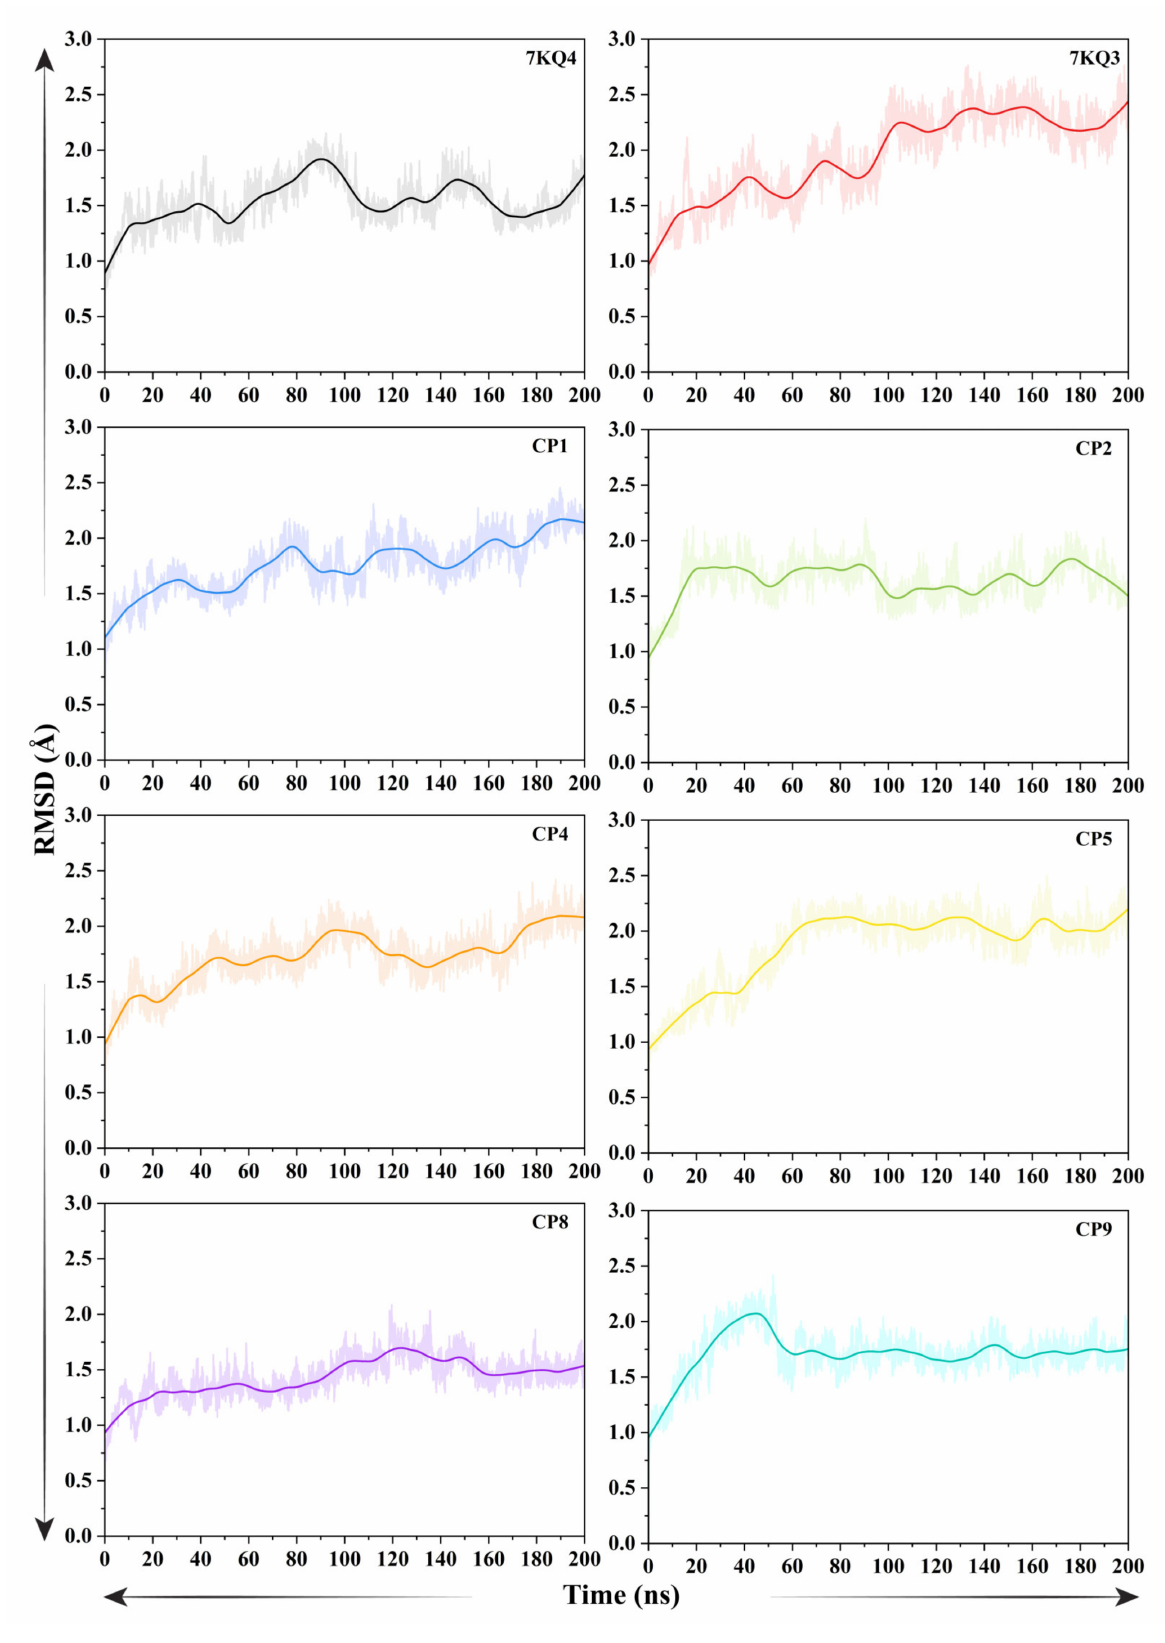
Figure 2. Root mean square deviation (RMSD) analysis of Isla in free state (7KQ4), reference-attached (7KQ3) and selected inhibitor